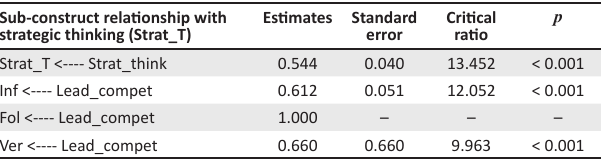
TABLE 12: Structural model parameter estimates and p -values for strategic thinking competency and leadership effectiveness. Sub-construct relationship with strategic thinking